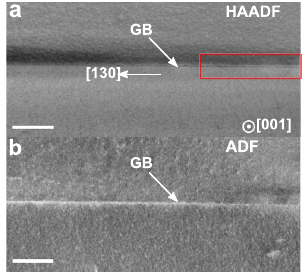
Fig. 1 Overview images of the Σ 5 (3 1 0 )[0 0 1] GB. a HAADF-STEM image and ( b ) corresponding low-angle ADF-STEM image showing bright contrast at the GB core indicating an accumulation of strain fi elds at the GB. The red rectangle in ( a ) indicates regions, which were imaged at atomic resolution. The scale bar is 100